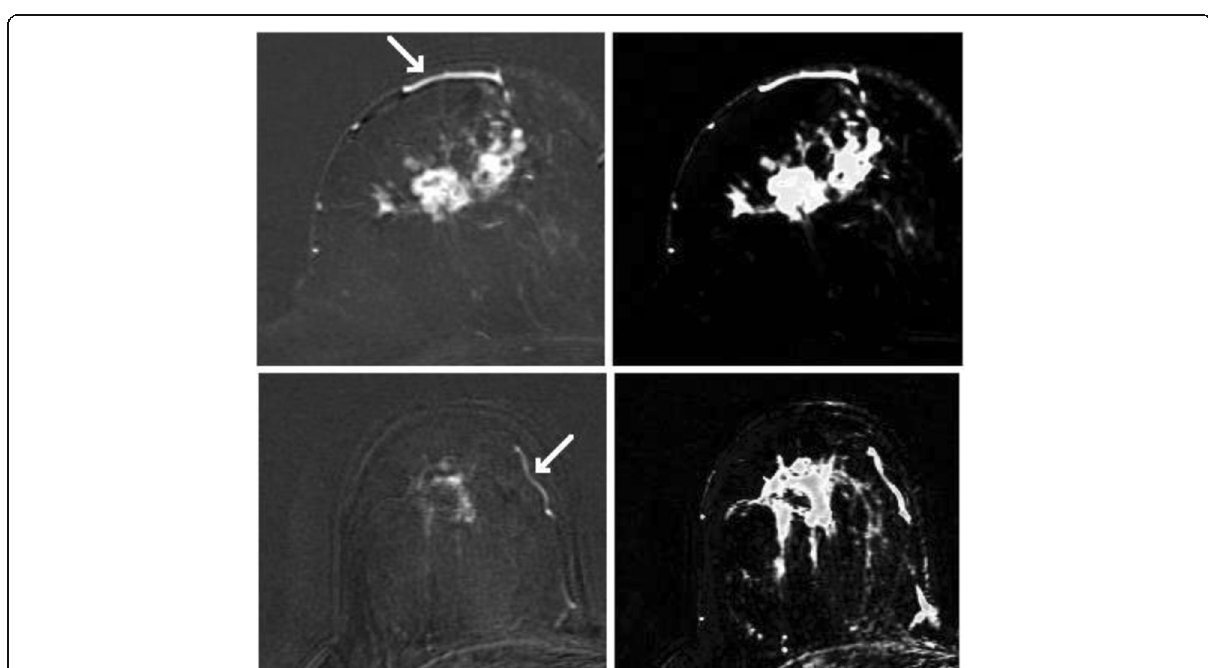
Fig. 5 The clustering results from the FCM method. The first column includes the subtracted image and its threshold at the first post-contrast time point, and the second column provides the lesion membership matrix obtained by FCM clustering. Mammary vessels ( arrows ) and breast lesions have similar